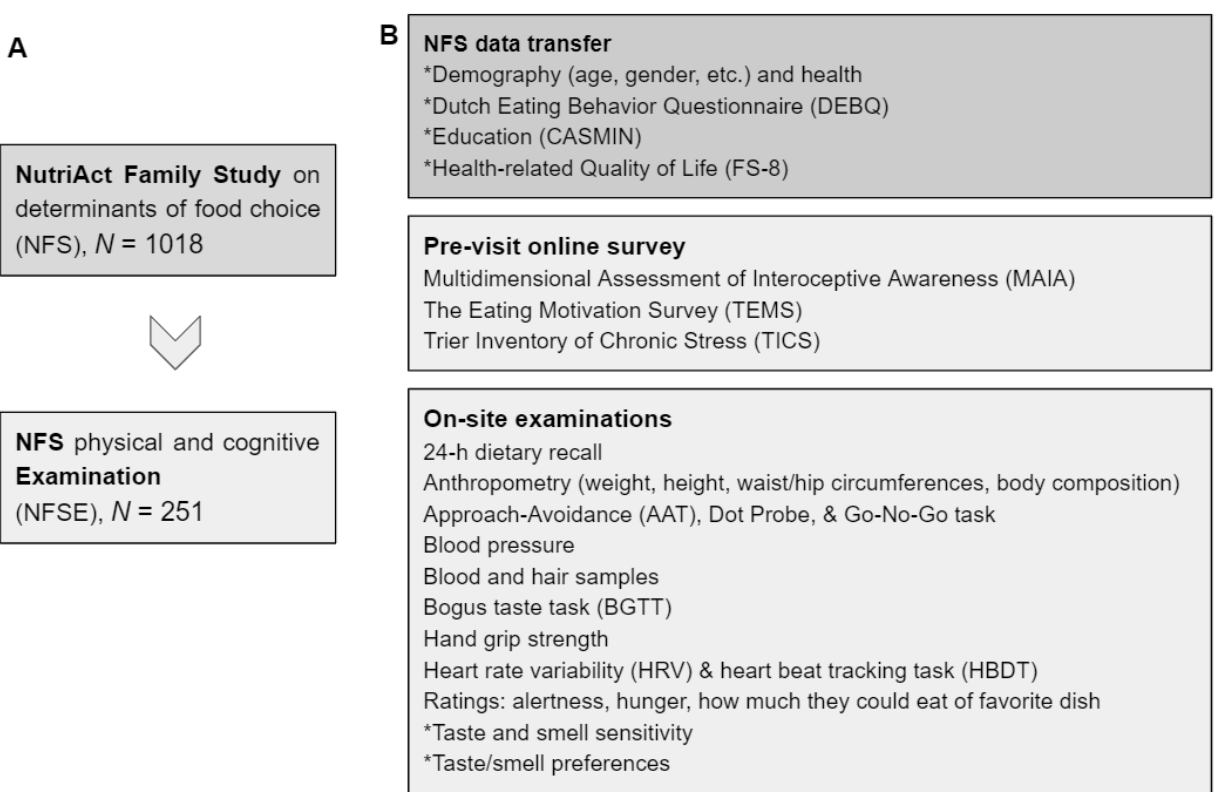
Figure 1. Design of the NFSE-he NutriAct Family Study on determinants of food choice (NFS) physical and cognitive Examinations. ( A ): A sub-sample ( N = 251) of the NFS participated in the NFSE. ( B ): Data collected from NFSE participants in three phases: during the NFS, during a pre-visit online survey, and during on-site examinations. The data reported here are indicated by a star (*).